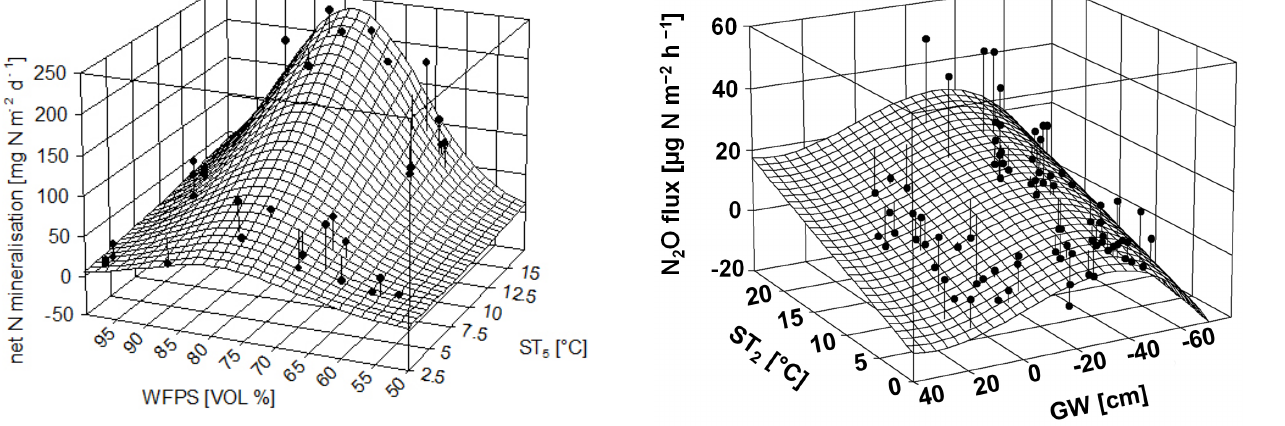
Figure 6. Relationship of mean N 2 O flux ( y ) to mean soil tem- perature in 2cm soil depth ( x 1) and to mean groundwater level ( x 2). Equation formula is y = − 4 . 884 ( ± 2.409) + 1.128 ( ± 0.179) · ST 2 + ( − 0.322) ( ± 0.086) · GW + 0.0004 ( ± 0.000) · GW 3 ( n = 80; adj − R 2 = 0 . 37; P < 0 .